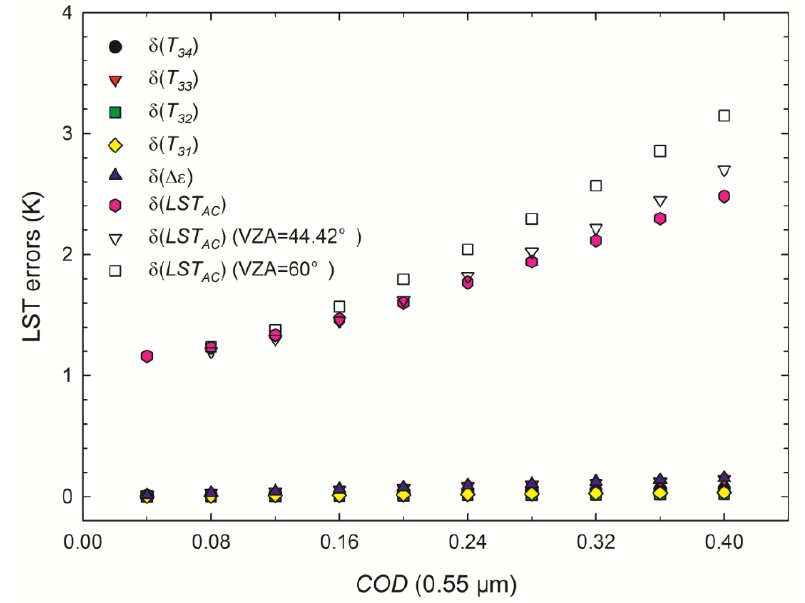
Figure 7. LST errors of  ( T i ) ( i = 31, 32, 33, and 34) and  (Δ ε ) caused by the uncertainties of T i and Δ ε , respectively, and the total LST errors (  ( LST AC )) in vertical view versus COD at 0.55 μm (solid symbols).  ( LST AC ) when VZA = 44.42° and 60° is shown in hollow triangles and hollow rectangles,